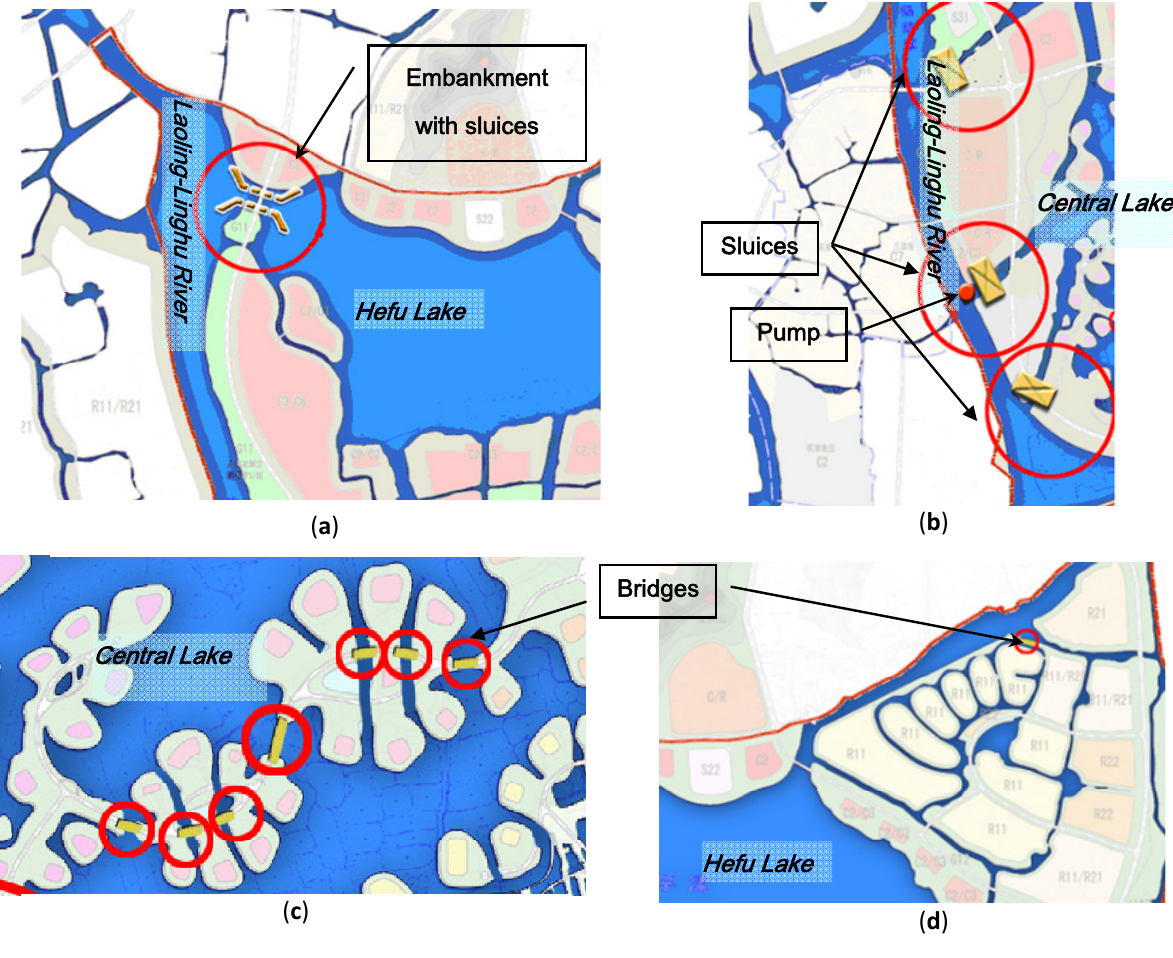
Figure 7. Projects for ecological functions: ( a ) Embankment with sluices at the junction of Laoling-Linghu River and Hefu Lake; ( b ) Sluices and pump at the junctions of the Laoling-Linghu River and the Central Lake; ( c ) and ( d ) Bridges in the Central Lake and the Residential